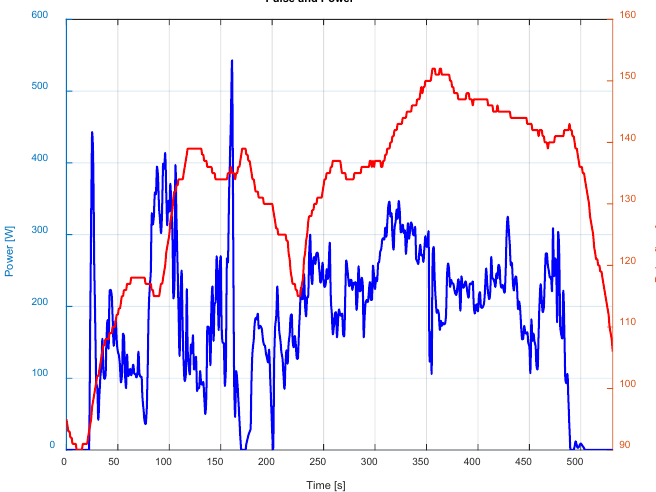
Figure 18. Power generated in a run without assistance and heart rate changes.